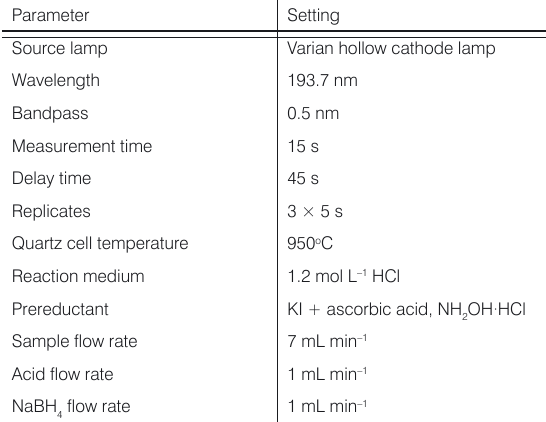
Table 1. Instrumental parameters for CF-HGAAS.